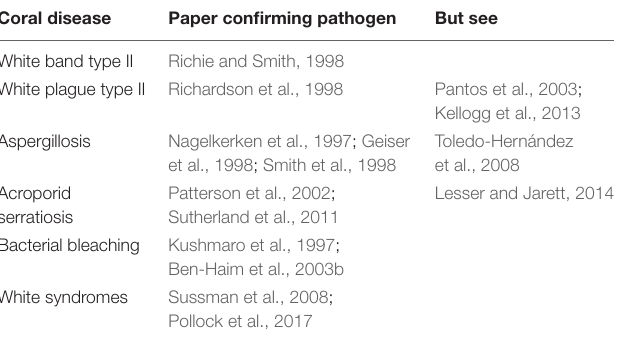
TABLE 1 | Coral disease studies confirming Koch’s Postulates and work refuting the findings.